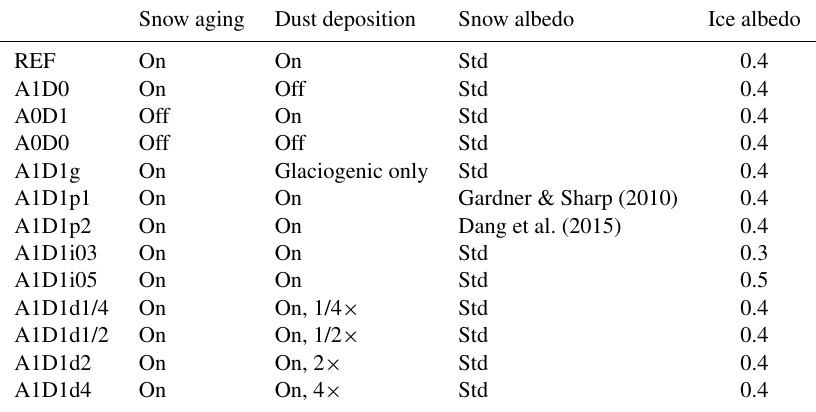
Table 1. List of online model simulations; std stands for “standard”. Snow aging Dust deposition Snow albedo Ice albedo REF On On Std 0.4 A1D0 On Off Std 0.4 A0D1 Off On Std 0.4 A0D0 Off Off Std 0.4 A1D1g On Glaciogenic only Std 0.4 A1D1p1 On On Gardner & Sharp (2010) 0.4 A1D1p2 On On Dang et al. (2015) A1D1i03 On On Std 0.3 A1D1i05 On On Std 0.5 A1D1d1/4 On On, 1/4 × Std 0.4 A1D1d1/2 On On, 1/2 × Std A1D1d2 On On, 2 × Std A1D1d4 On On, 4 ×